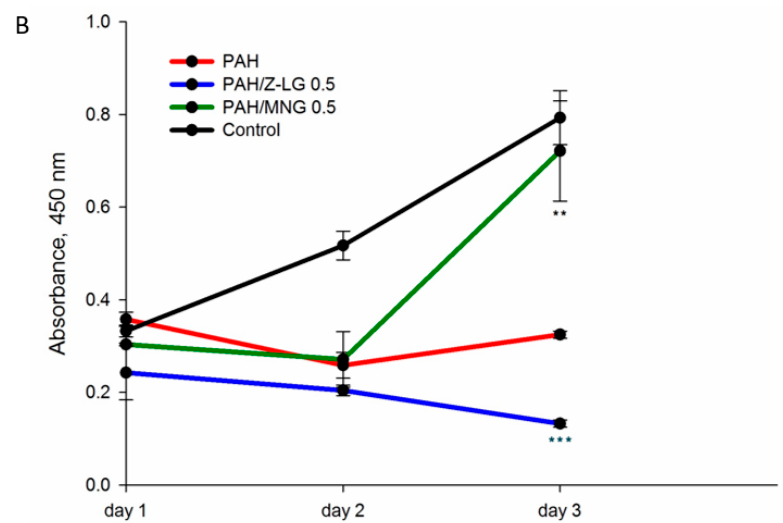
Figure 1. The effects of polycyclic aromatic hydrocarbons (PAH) extract (containing 2nM of benzo(a)pyrene (BaP)), Z-ligustillide (Z-LG, 0.5 µg/mL), mangiferin (MNG, 0.5 µg/mL) or combination thereof on proliferation of human bronchial epithelial cells. In the graph A a 3-day proliferation rate of bronchial epithelium BEAS-2B cells exposed to PAH extract (red plot) is represented in comparison to control (black plot), MNG- (green plot) and Z-LG exposed cells (blue plot). Proliferation rate of cells exposed to the combinations of PAH/MNG (green plot) and PAH/Z-LG (blue plot) is shown in the graph B and compared to the PAH-exposed cells (red plot). Proliferation was monitored by Cell Counting Kit-8 (CCK-8) assay measuring adsorption at 450 nm every 24 h. Data are presented as means ± SD. Each point represents at least three independent experiments. Significance is indicated as follows: * for p < 0.05, ** for p < 0.01, *** for p < 0.001.